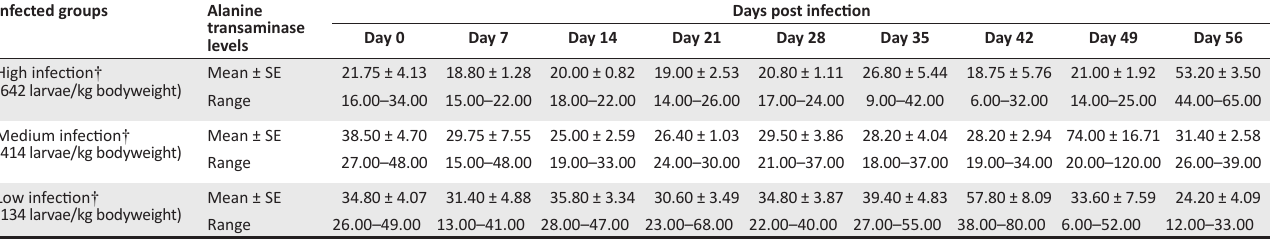
TABLE 4: Mean aspartate transaminase levels (IU/L) of Nile crocodiles ( Crocodylus niloticus ) experimentally infected with Trichinella zimbabwensis. Infected groups